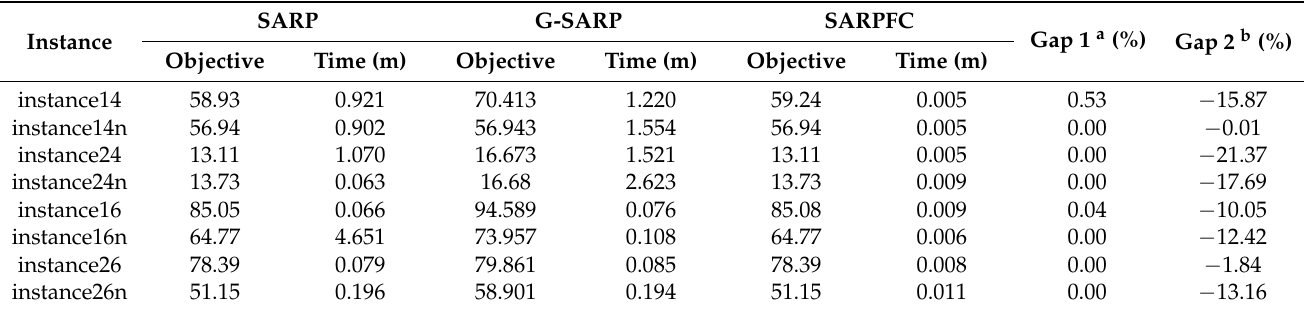
Table 5. Comparison between SARP, G-SARP, and SARPFC solution for small instance.